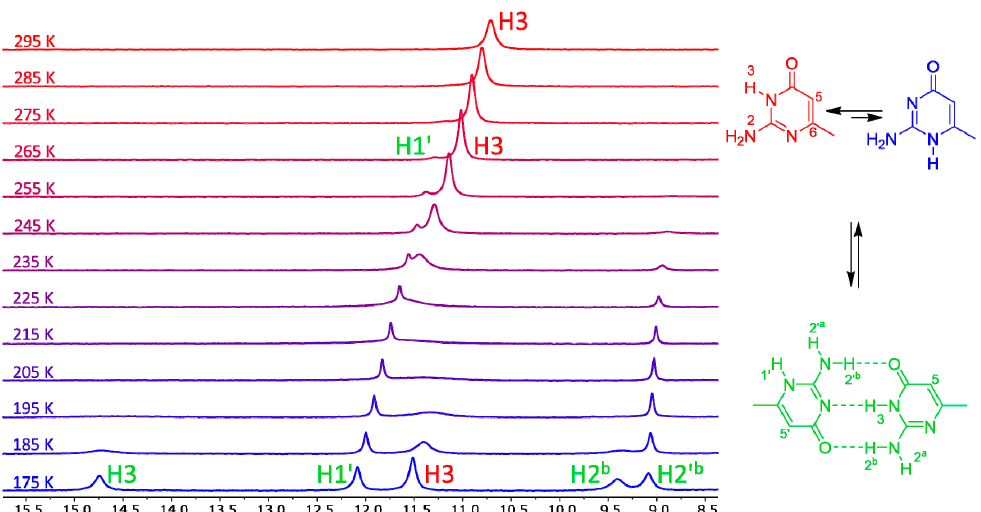
Figure 3. The low-field regions of variable-temperature 1 H-NMR spectra of compound 7 in a 3:1 mixture of dimethylformamide (DMF)- d 7 and CD 2 Cl 2 . Signals of imino hydrogens H1 ′ and H3, together with signals of amino hydrogens involved in intermolecular hydrogen bonds, appear in this spectral region. Another spectral region is shown in the SI (Figure S1).